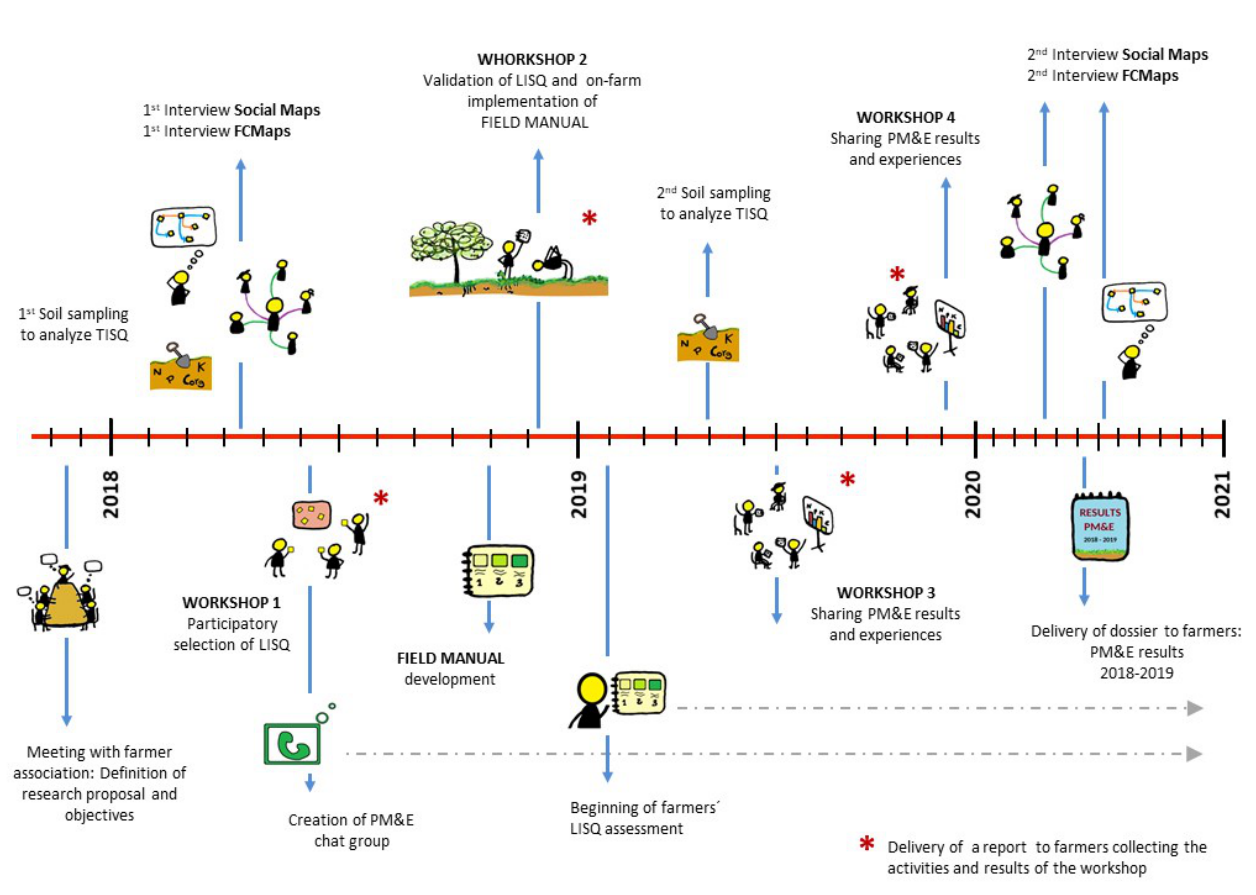
Fig. 1. Timeline of the participatory monitoring and evaluation (PM&E) project, displaying the main events. The current research presents the results and analysis of the first and second interview rounds applying fuzzy cognitive mapping and social network analysis. Monthly spacing has been reduced in the timeline each year to enhance the representation of events. TISQ =